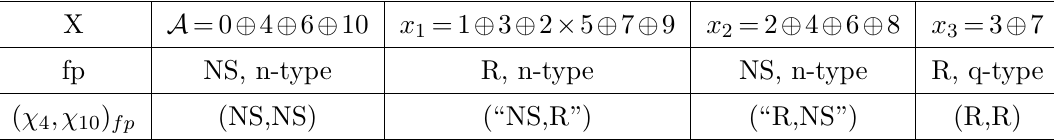
Table 6 . Defects (modules) at the gapped boundary where A